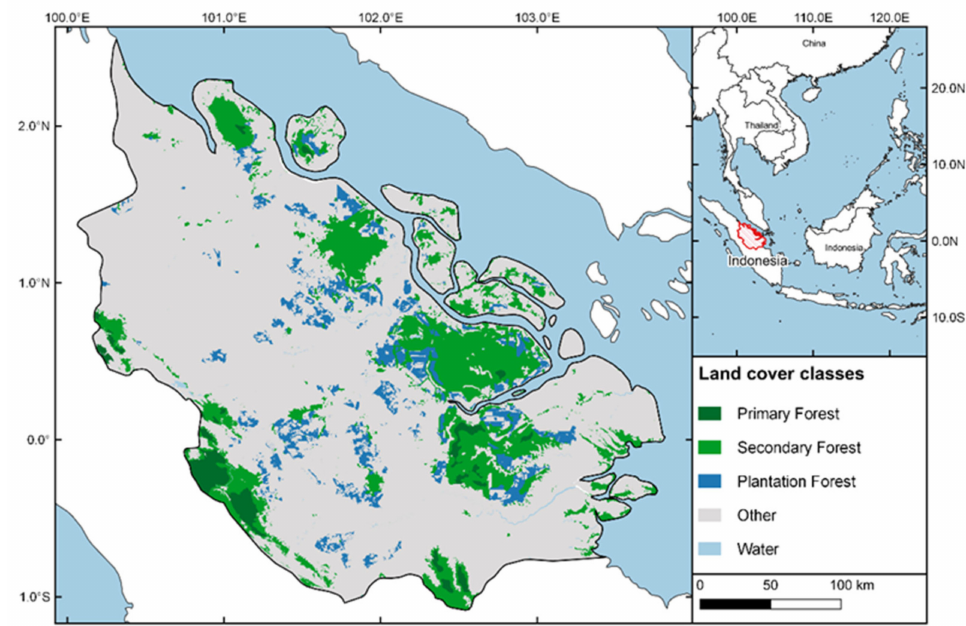
Figure 1. Forest types in the province of Riau (Indonesia) for 2017 [53].